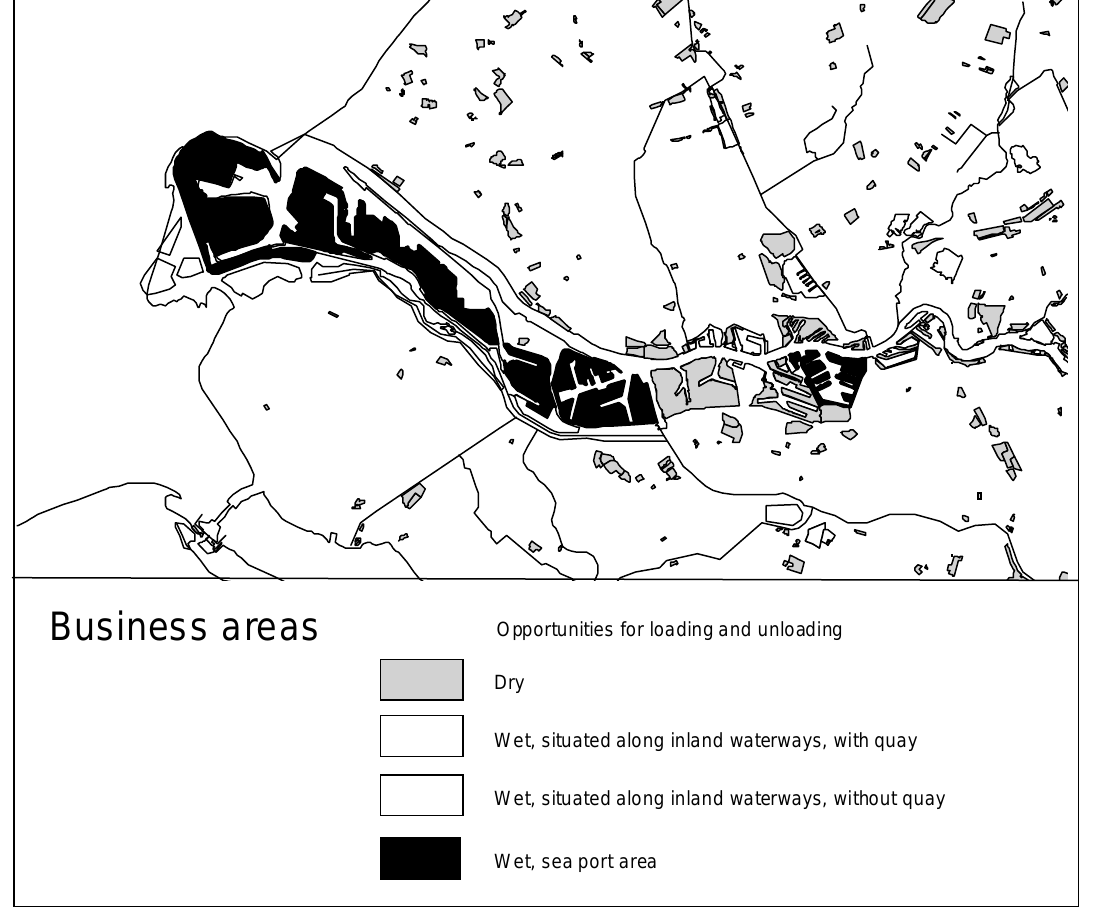
Figure 3. Companies in and around mainport